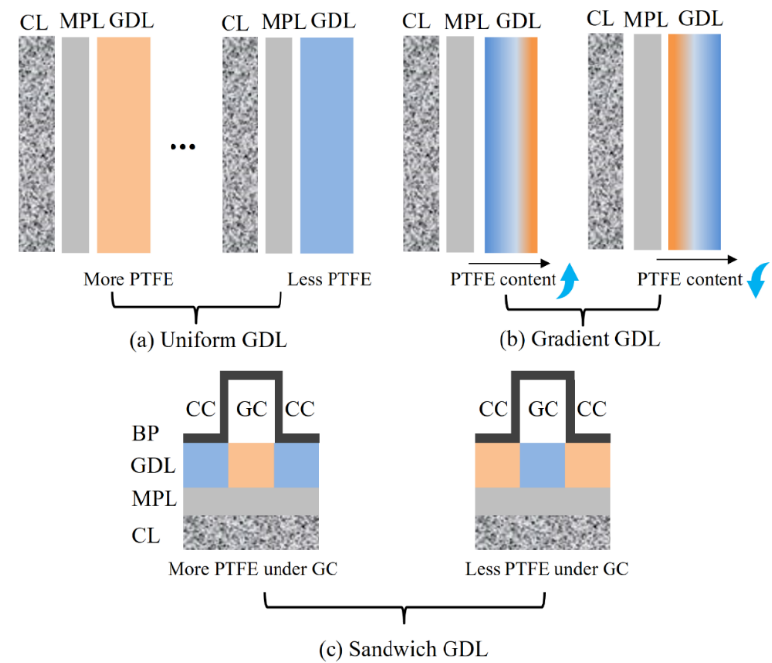
Figure 2. Schematic of GDL designs with different PTFE doping strategies.